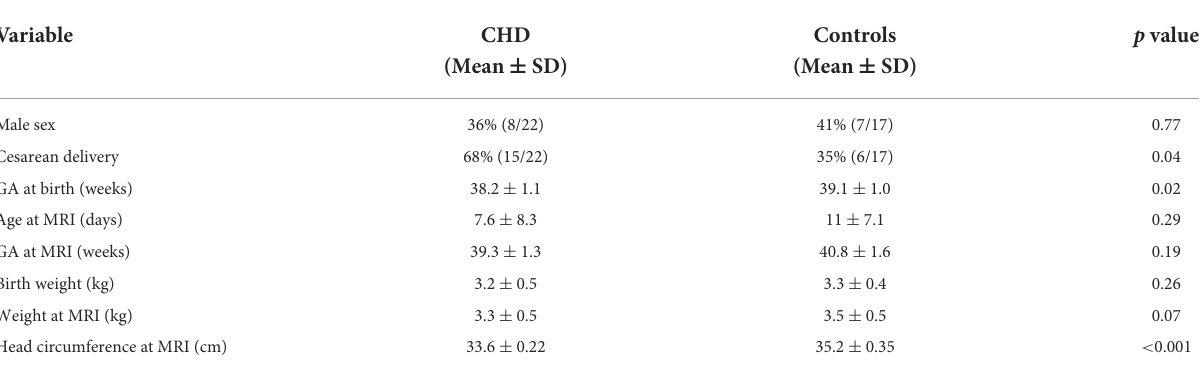
TABLE 1 Demographic and characteristics of the